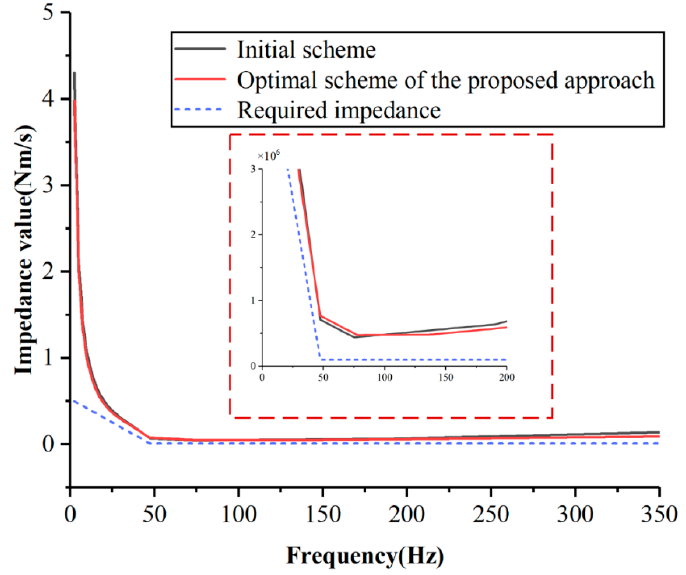
Figure 10. The impedance curve of the optimization solution.